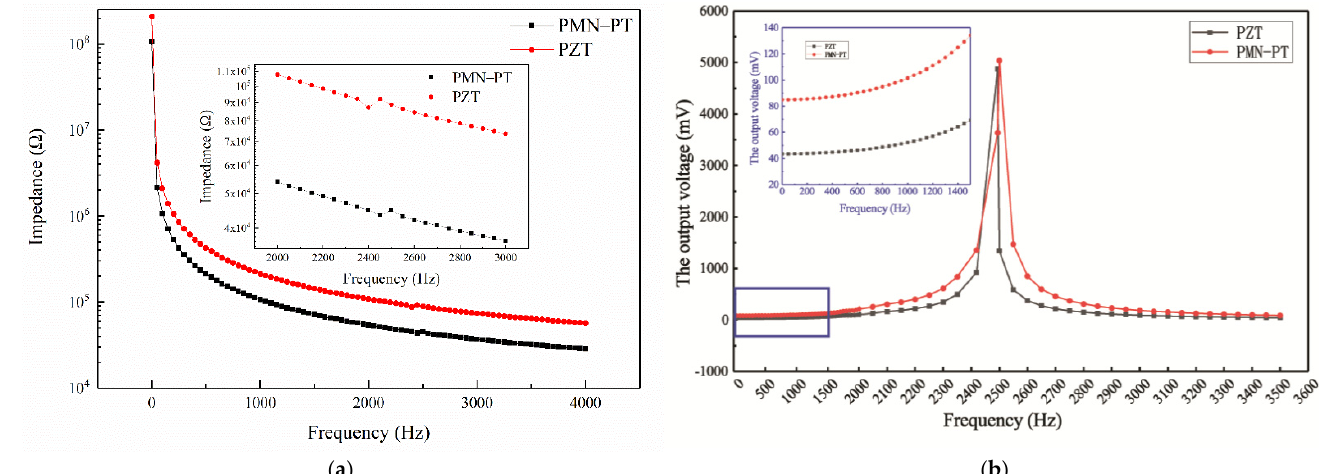
Figure 6. ( a ) The impedance spectrum of PMN-PT and PZT; ( b ) The output voltage of the models based on PMN-PT and PZT.